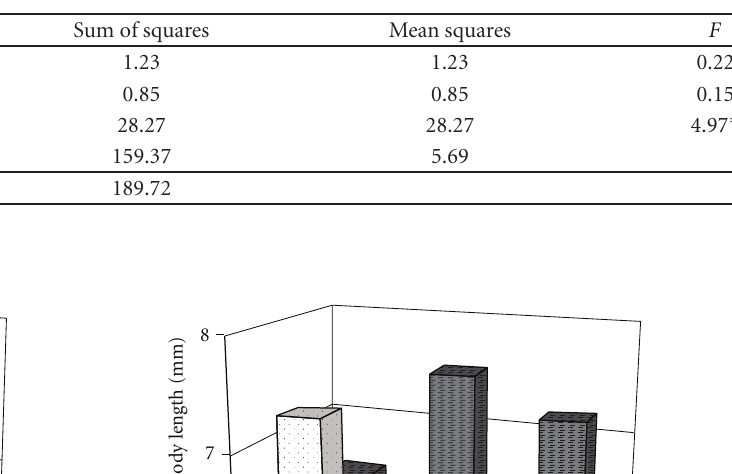
Figure 7: Individual electrophoretic spectrums of amplified DNA fragmentsfrom leaves of 14 model oakswith primer OPA 14; M: molecular markers (100–1000bp). Table 4: Results of two-way ANOVA on the parasitoid thorax lengths variation in dependence on the parasitoid tibia phenotype and genotypes of oaks (presence or absence of the OPA 14-4 DNA fraction; see Figure 8).